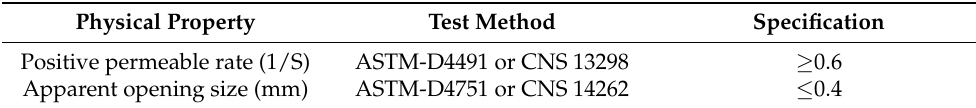
Table 3. Material specification of geotextile in Section II.